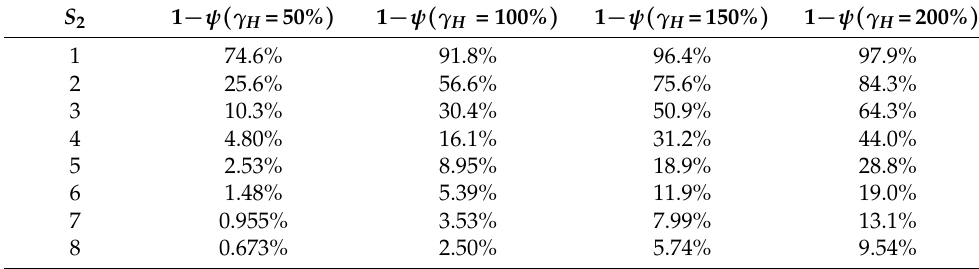
Table 1. Percentage reduction of the ψ function with the shear strain for different values of the secondary shape